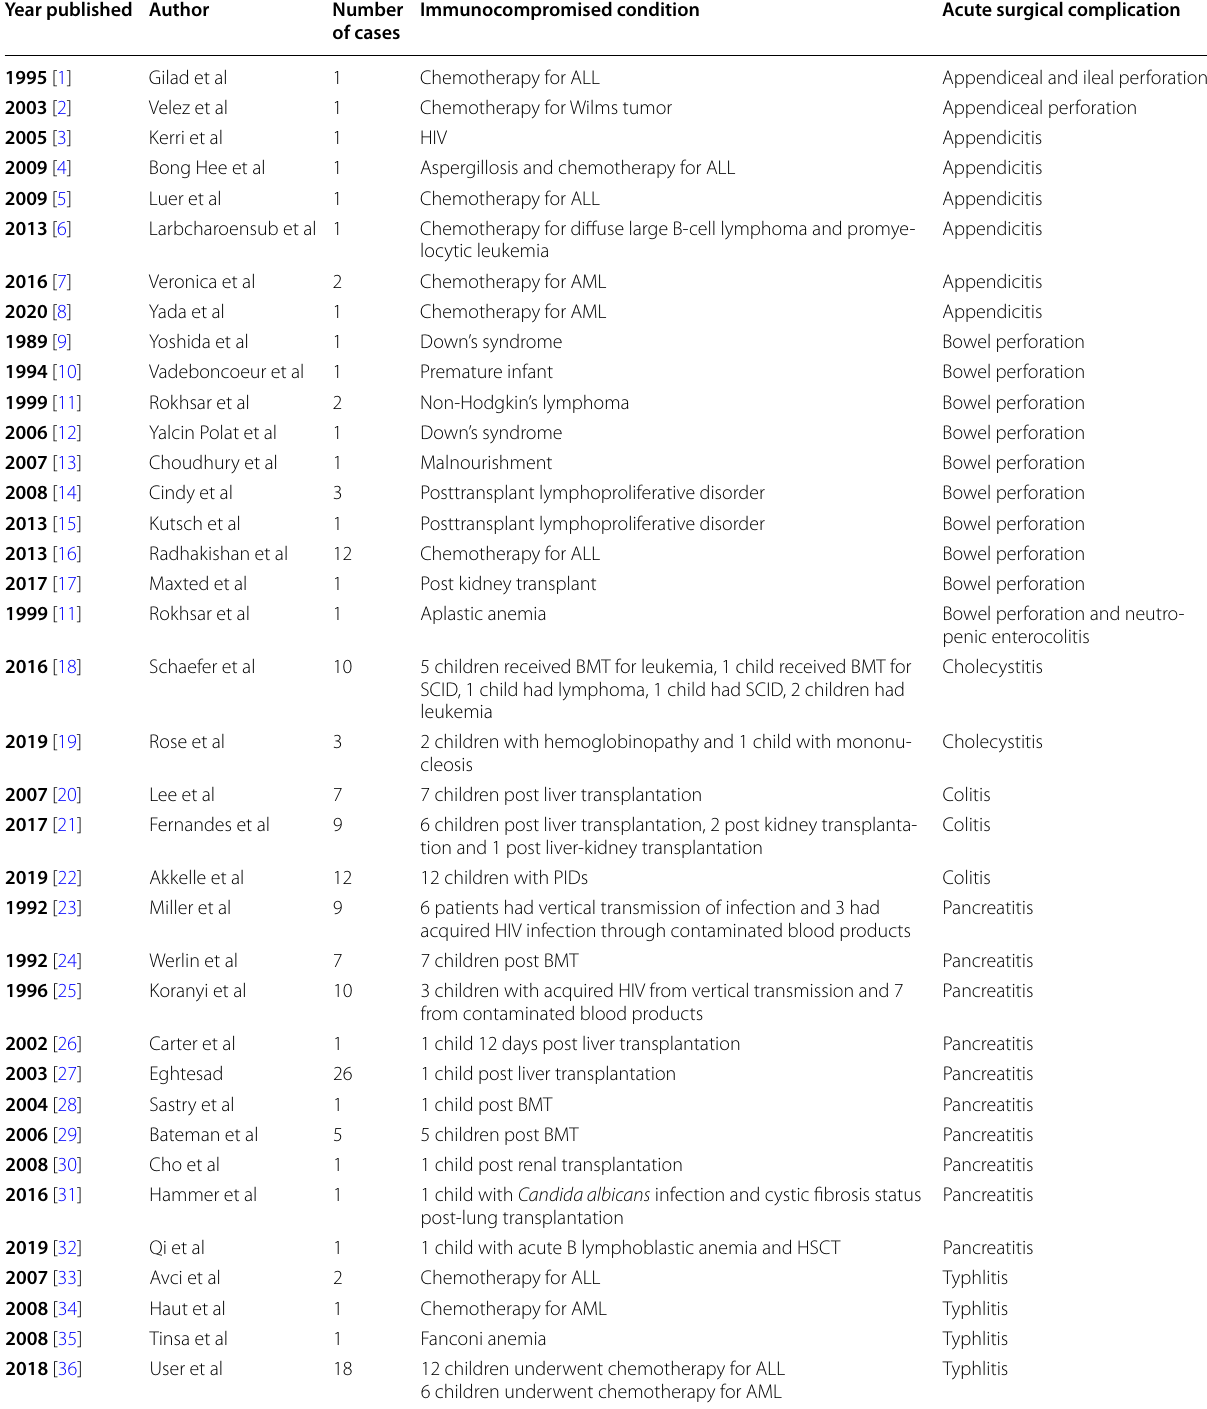
ALL, acute lymphocytic leukemia; HIV, human immunodeficiency virus; AML, acute myeloid leukemia; BMT, bone marrow transplant; SCID, severe combined immunodeficiency disorder; PID, primary immunodeficiency disorder; HSCT, hematopoietic stem cell